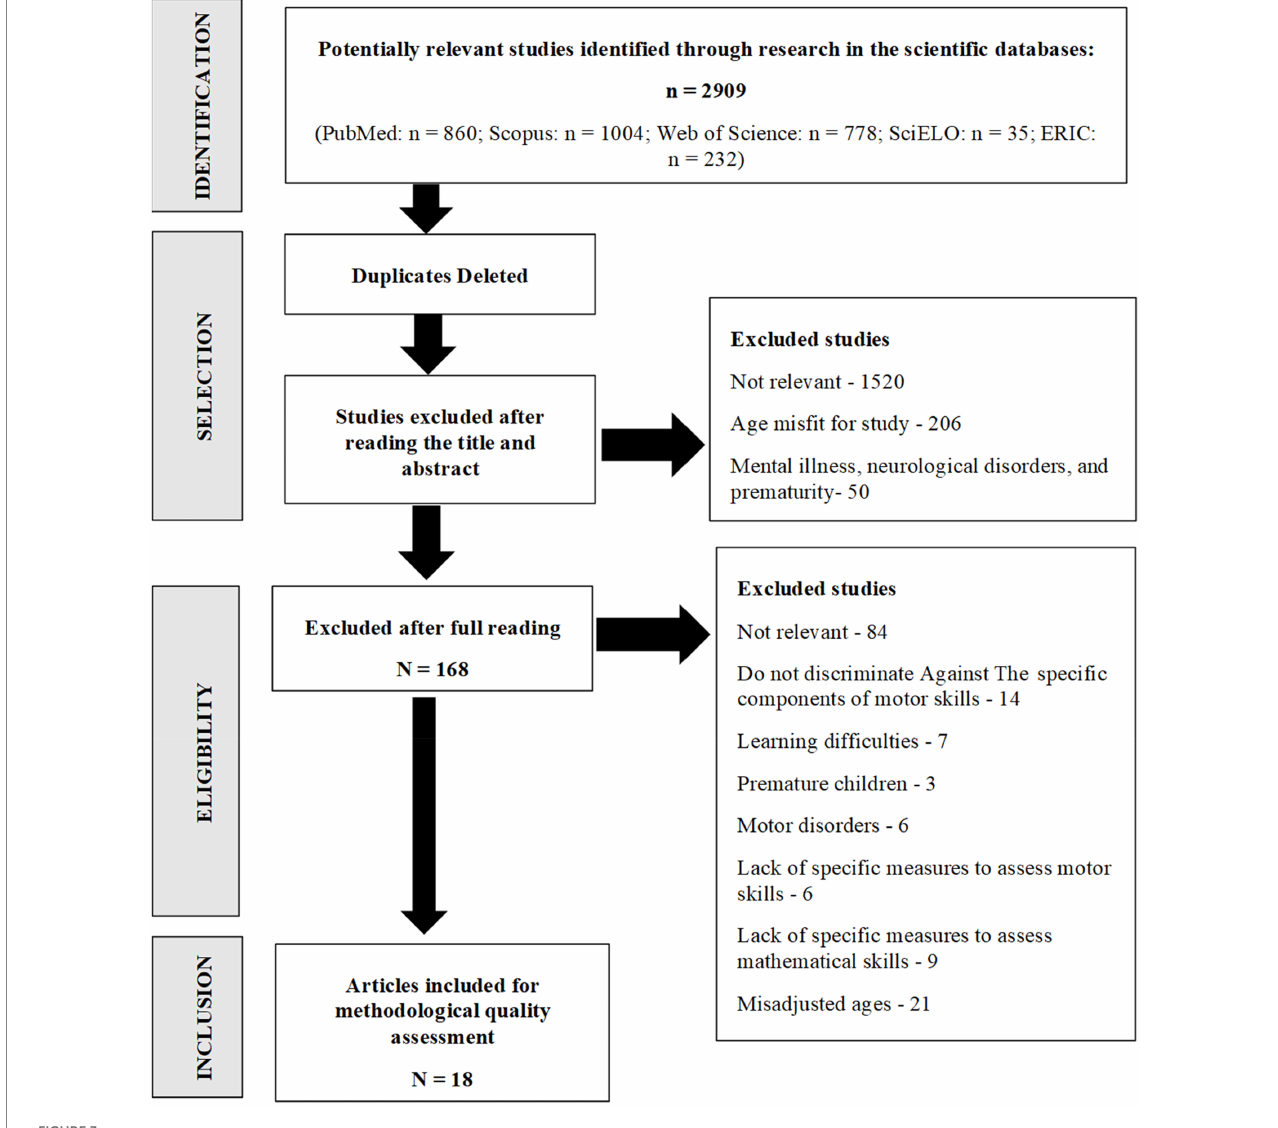
FIGURE 3 Flowchart of research processes for the inclusion of studies